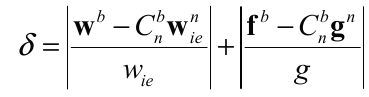
Figure 7. Flowchart for the selective alignment